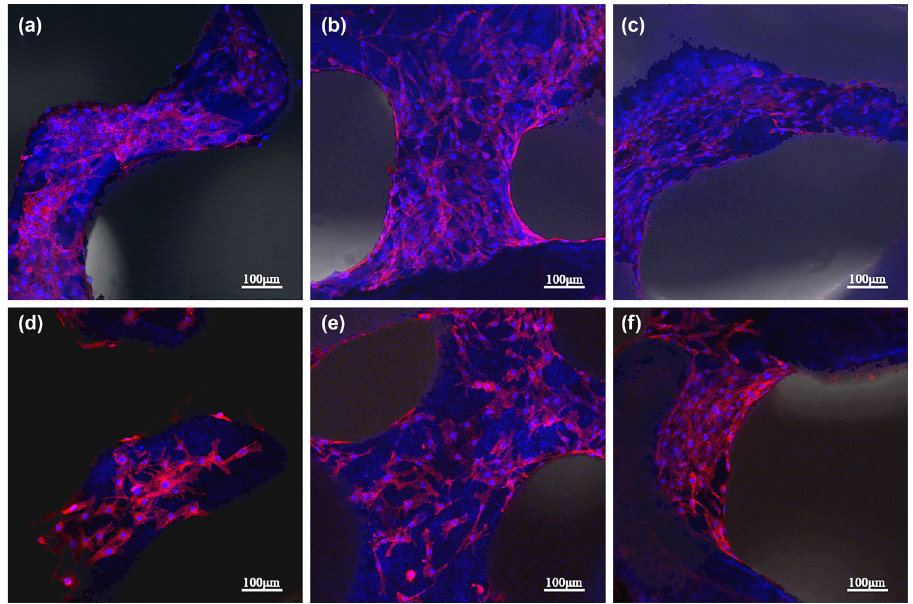
Figure 4: Cells on di ff erent typical structures in the stressed and control groups. Synthetic images of nucleus and F - actin of cells on the surface ( a and d ) ; connection ( b and e ) ; pore wall ( c and f ) ; ( a – c ) stressed group; ( d – f ) control